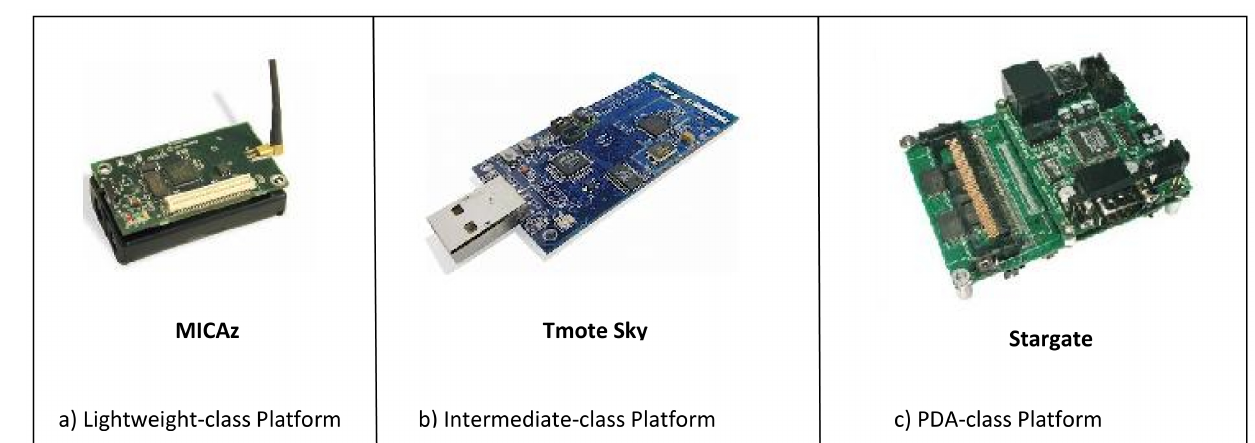
Figure 5. Examples of Wireless Mote